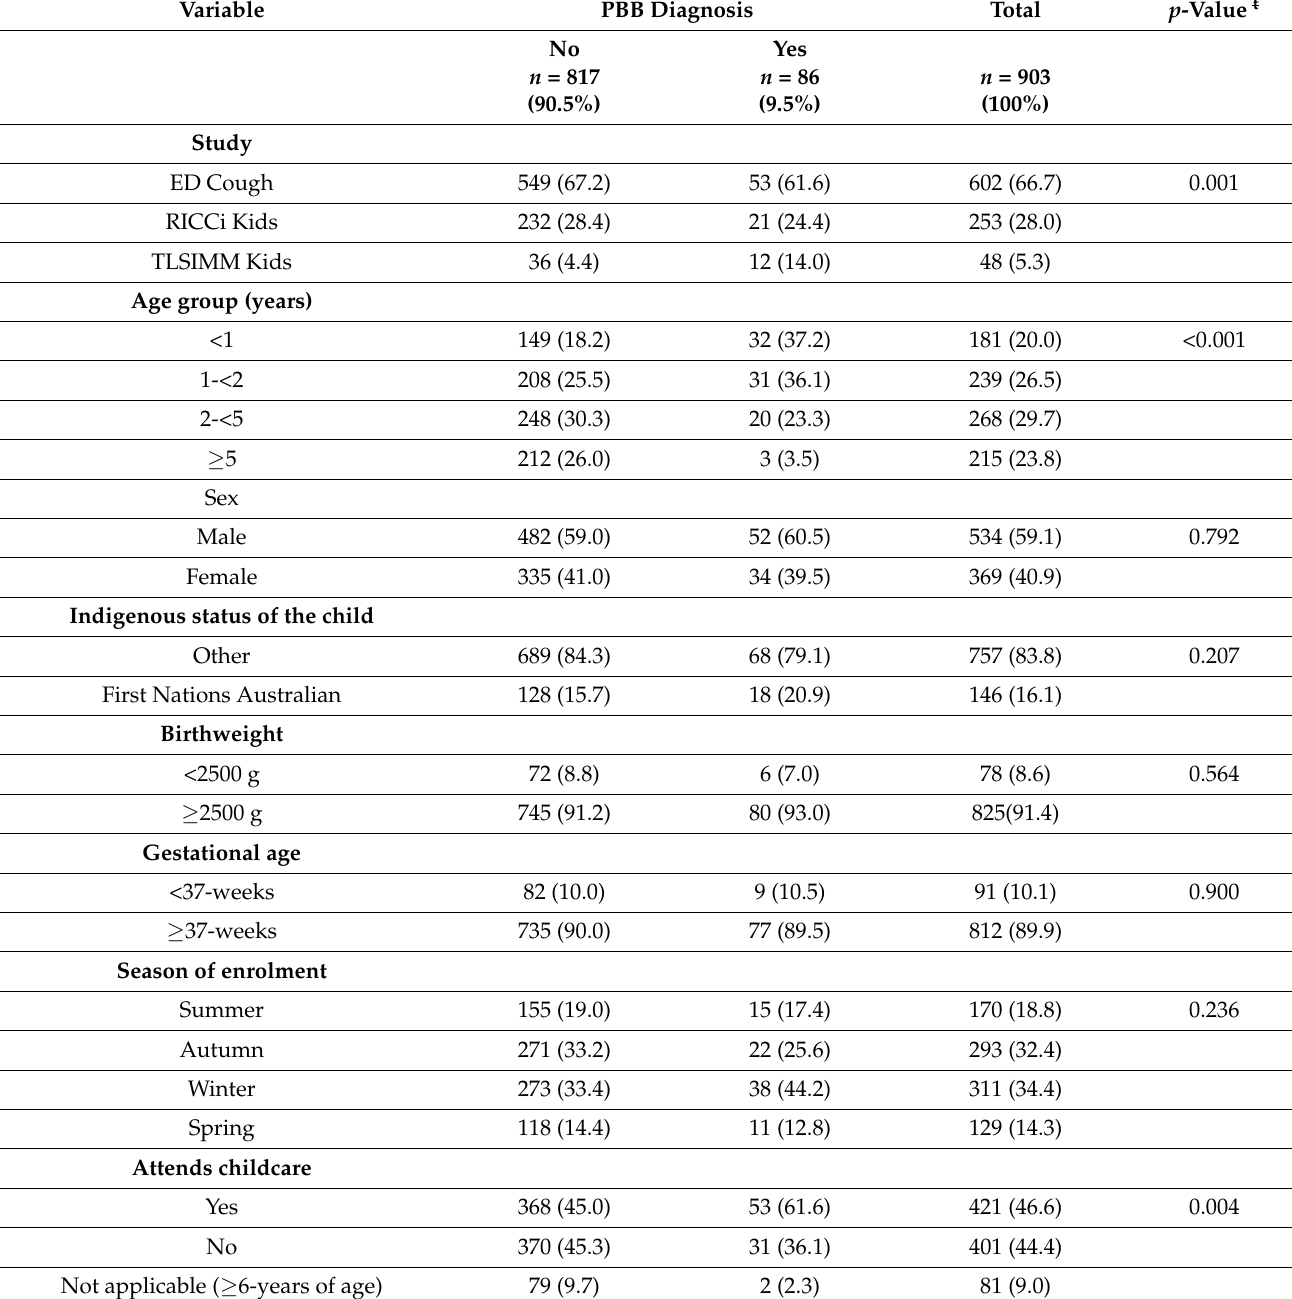
Table 1. Baseline characteristics of children presenting with cough duration <14-days by a diagnosis of PBB following day-28